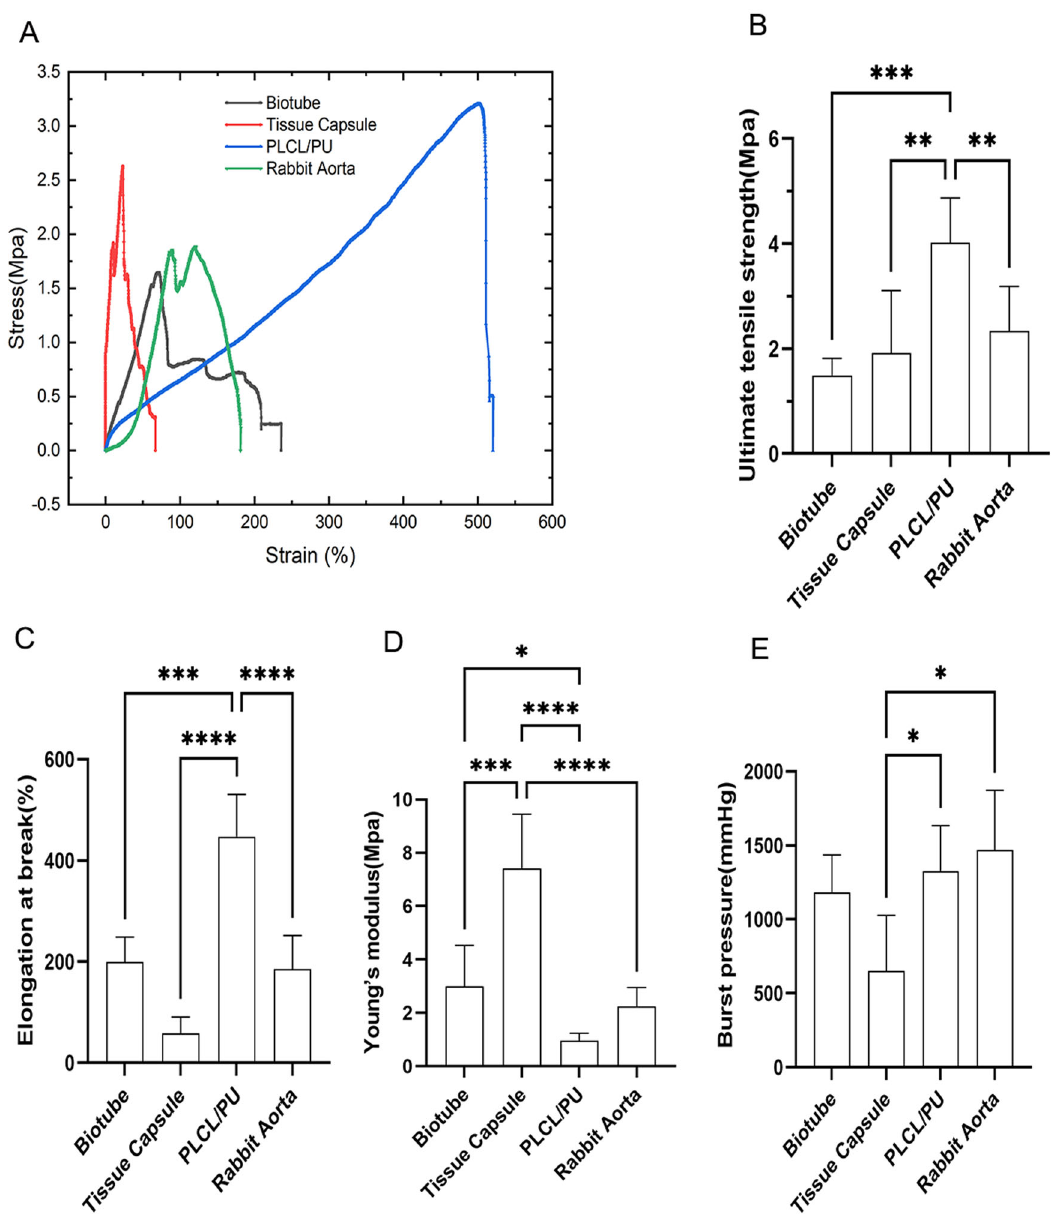
Fig. 5 The mechanical properties (circumferential) of the biotube, tissue capsule, PLCL/PU(no embedding), and rabbit aorta. Stress-strain curve ( A ), Ultimate tensile strength ( B ), Elongation at break ( C ), Young ’ s modulus ( D ), Burst pressure ( E